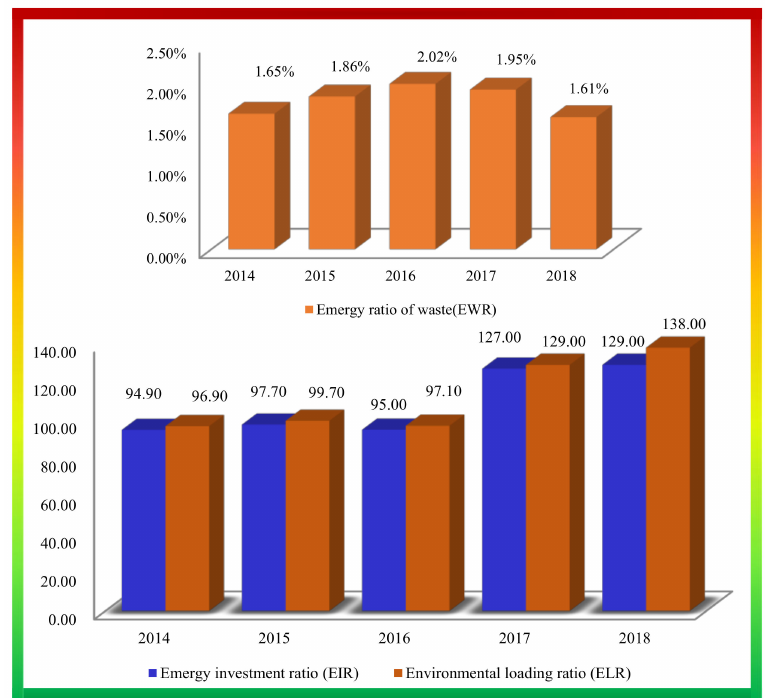
Figure 4. Analysis of ecological e ffi ciency evaluation